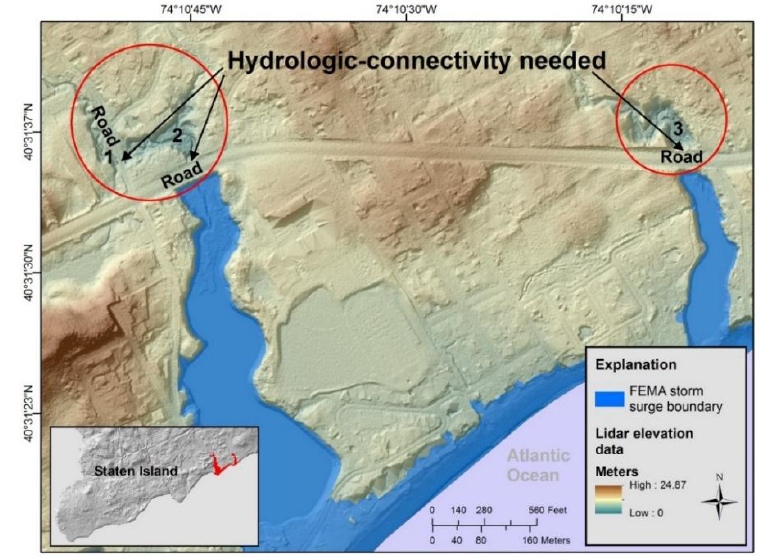
Figure 4. Federal Emergency Management Agency (FEMA) Modeling Task Force (MOTF)-Hurricane Sandy Impact Analysis storm surge boundary. The boundary is overlain on a high-resolution lidar elevation shaded relief. Inland areas that are inundated in Figure 3 (red circles) are not included in the FEMA MOTF storm surge boundary shown in this figure. This is what the coastal inundation would look like if the roads were not